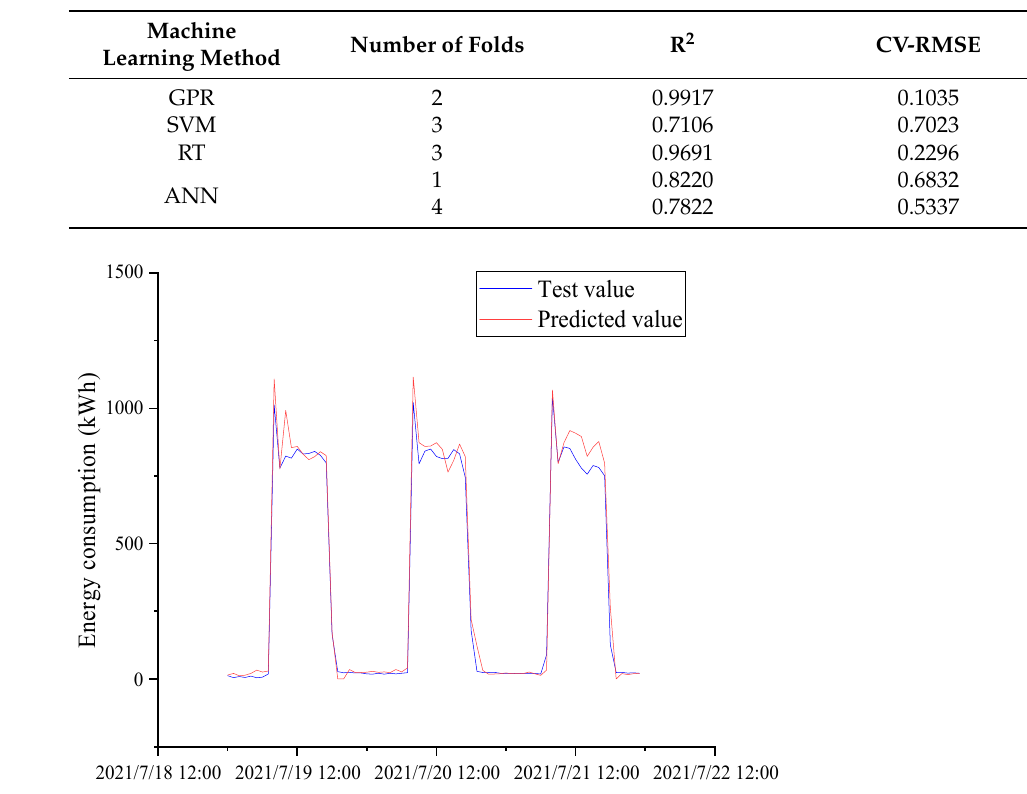
Figure 12. Fitting curve with Gaussian progress regression. ( a ) Training (SVM). ( b ) Test (SVM). ( c ) Training (RT). ( d ) Test (RT). ( e ) Training (ANN with 1-fold cross-validation). ( f ) Test (ANN with 1-fold cross-validation). ( g ) Training (ANN with 4-fold cross-validation). ( h ) Test (ANN with 4-fold cross-validation). Table 2. Predicted air-conditioning energy consumption, folding number, and precision index.